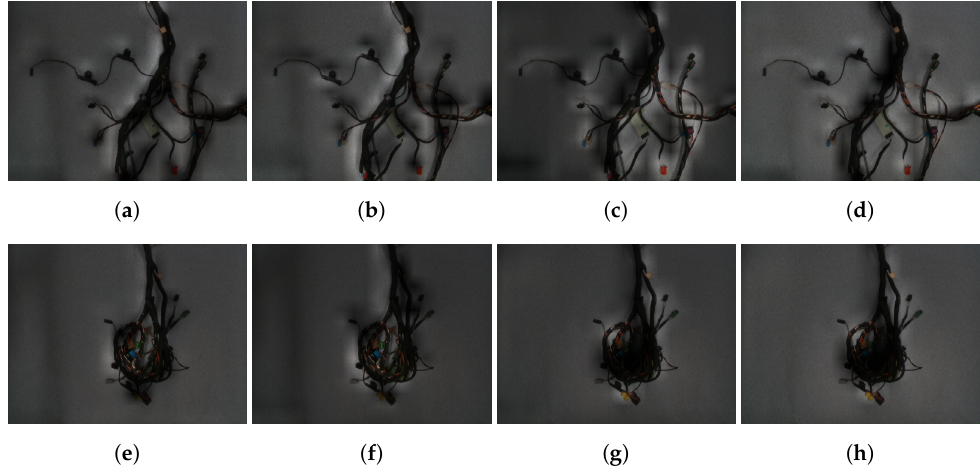
Figure 7. Class activation saliency maps, superimposed on the 2 different RGB images, conditioned on 4 classes ( branch 1–4 from left to right). Top row ( a – d ) contains the saliency maps obtained for the successful classification (ground truth and predicted class: branch 3 —( c )), while in the bottom row ( e – h ) for a failure case (ground truth class: branch 3 —( g ), predicted class: branch 4 —( h )). For the successful scenario neural network focuses its attention to the specific parts of the branch 3 ( c ), while for other classes ( a , b , d ) it can not find relevant parts of the branch. In the failure case, tangled branch occludes the parts of the branch important for distinguishing between the classes. Neural network finds an evidence both for branch 3 —( g ) and branch 4 —( h ) and it is unable to correctly decide which is more